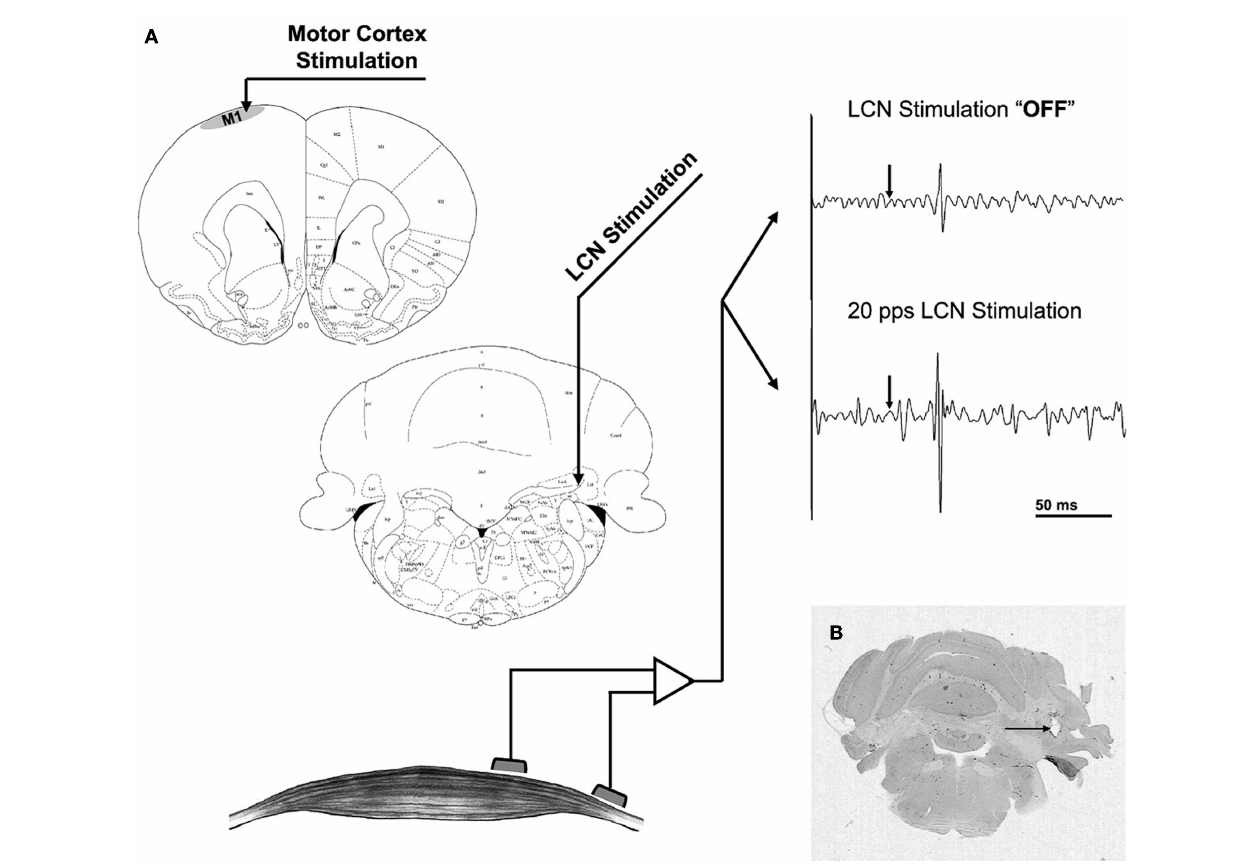
a 200-ms segment, comprised of a 50-ms baseline followed by a 150-ms response window.The arrow represents the time of intracortical stimulation. (B) Coronal cut of the rat’s cerebellum stained for H&E.The artifact corresponding to the tip of the macroelectrode targeted at the LCN can be seen (arrow).With permission from Elsevier Limited